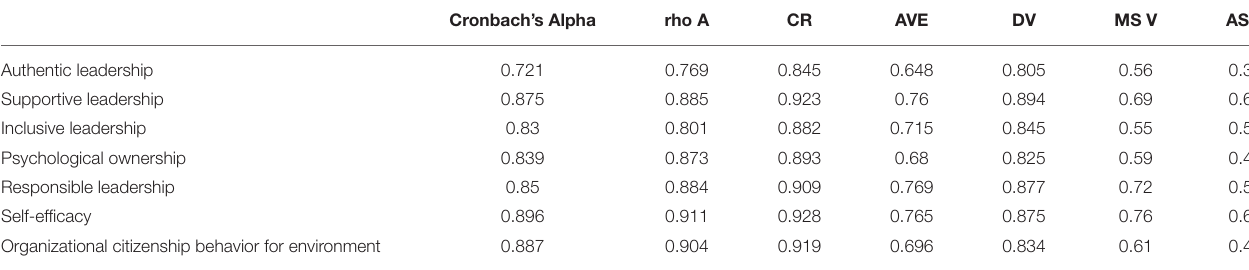
TABLE 2 | Composite reliability, Cronbach’s alpha, average variance extracted, and discriminant validity among study